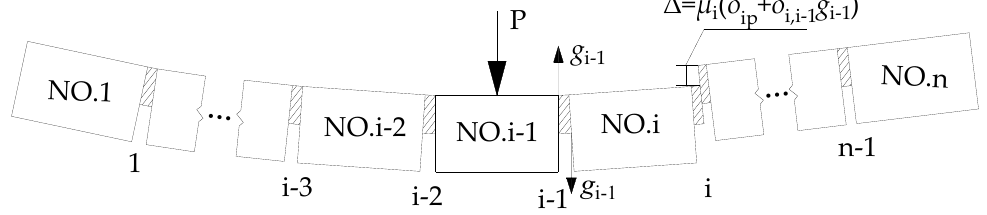
Figure 4. Illustration of the damage factor for i th hinge.